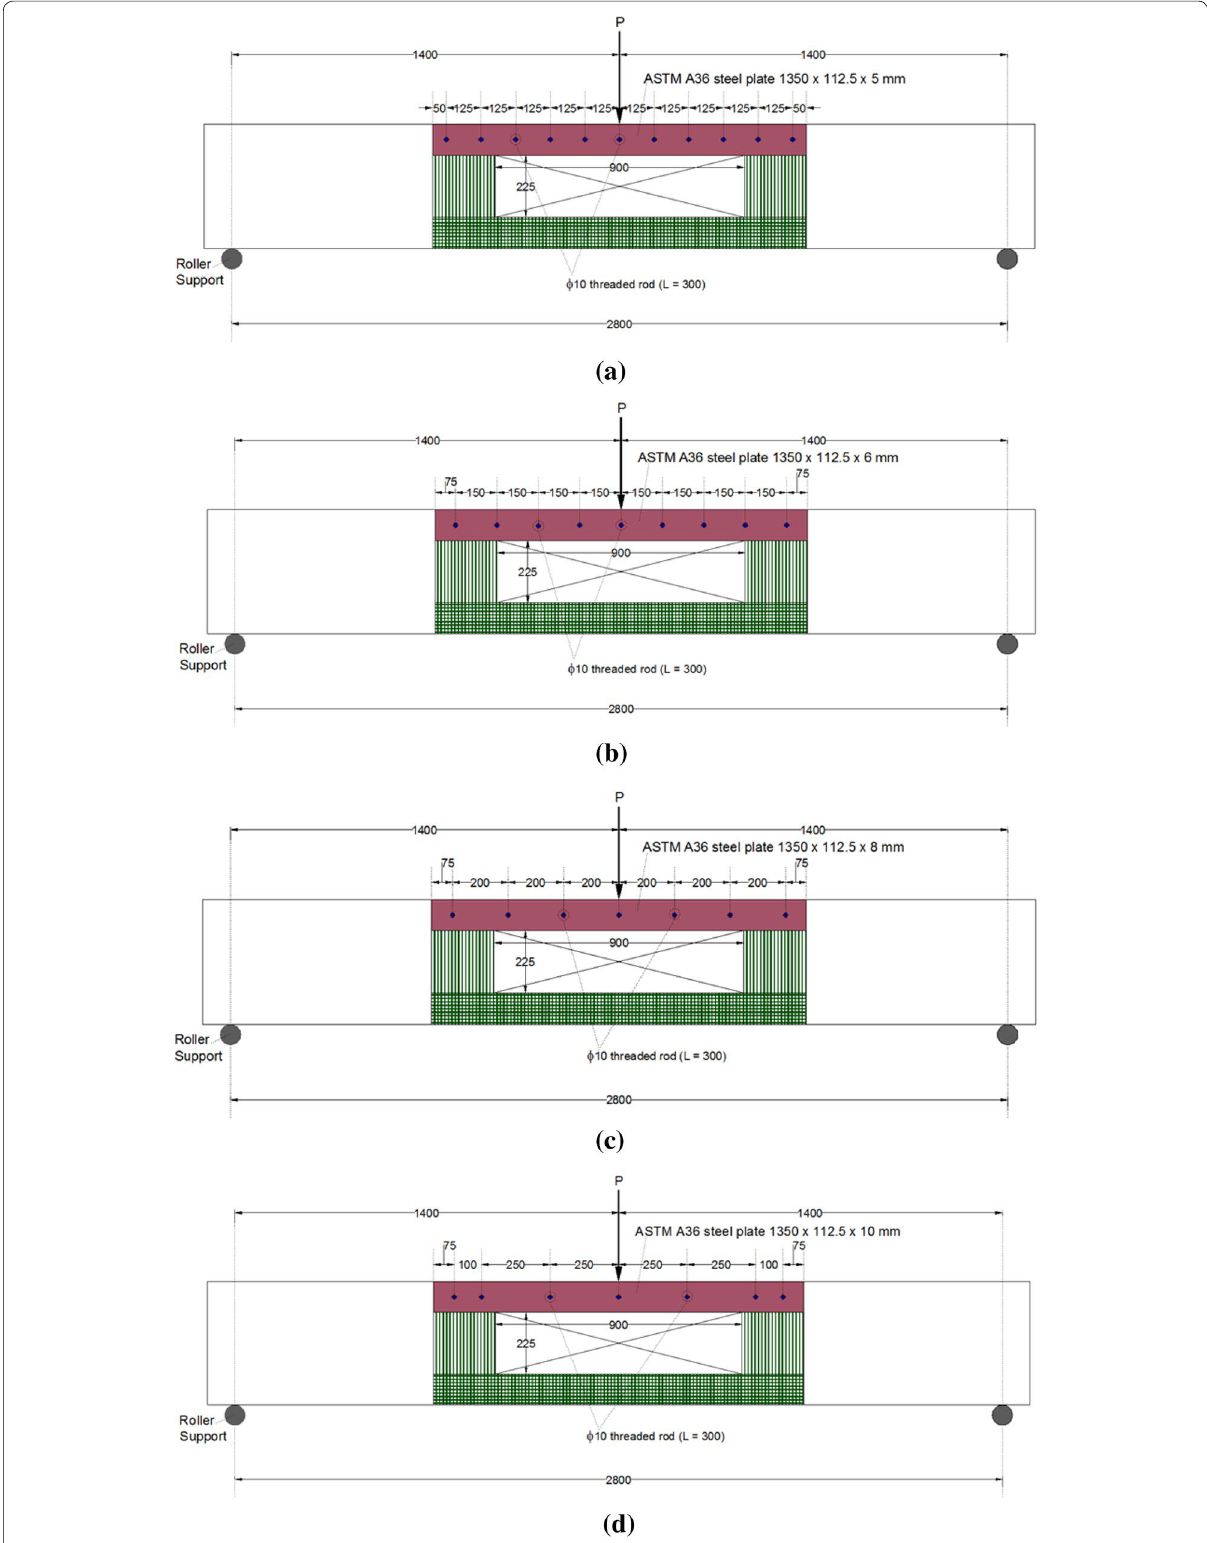
Fig. 17 Details of proposed strengthening schemes for beams with 900 mm opening (Note: all dimensions are in mm): a scheme‑3, b scheme‑4, c scheme‑5, and d